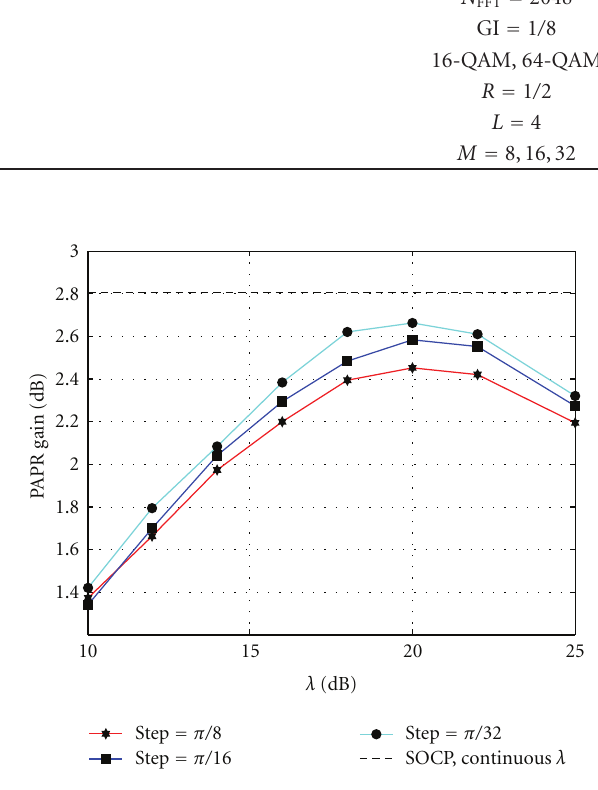
Figure 10: PAPR gain at a CCDF = 10 − 3 as a function of λ , M = 8, 16-QAM.